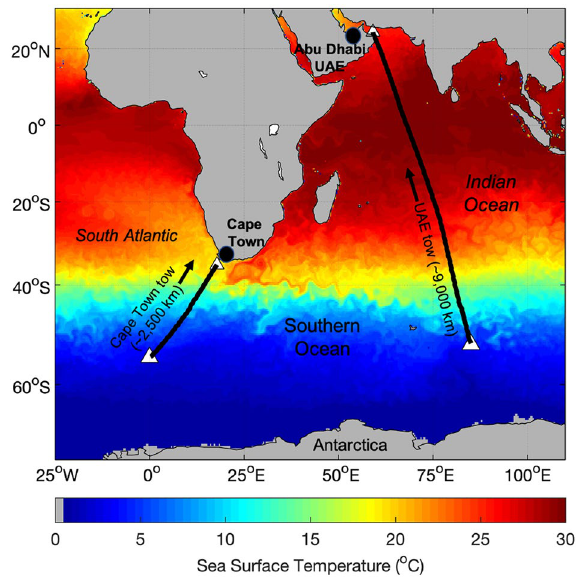
Figure 1. Simulated iceberg tow routes. Antarctic icebergs were towed from 55°S,0° W to Cape Town, South Africa [~ 2500 km] and from 52°30 ′ S, 85° E to the United Arab Emirates (UAE) [~ 9000 km]. The blue-red colours show a snapshot of model simulated sea surface temperature (SST) for the month of April to illustrate that in order to reach these destinations, icebergs must be moved through subtropical-tropical (20 °C +) waters for long periods of